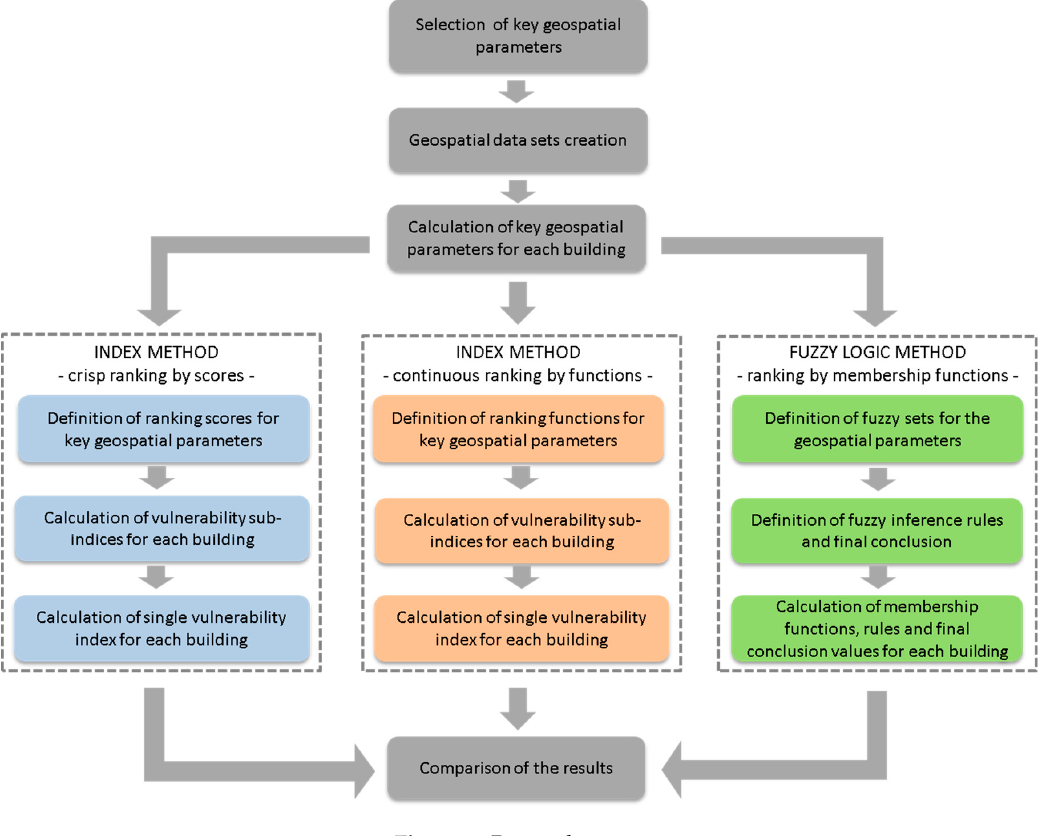
Figure 1. Research steps.